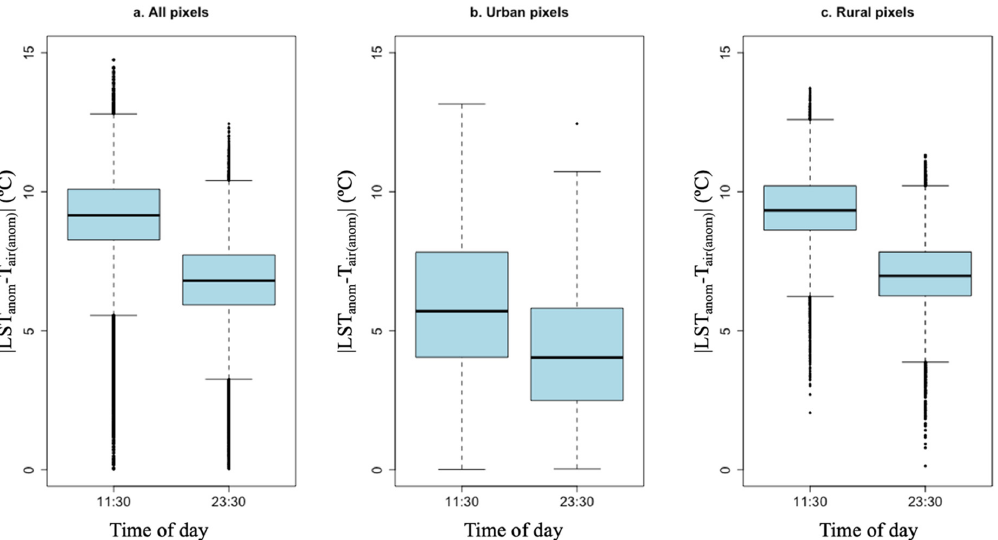
Figure 3. The absolute magnitude of the difference between LST anom and T air(anom) by time of day, averaged over all 15 dates of study across ( a ) all pixels, ( b ) all urban pixels, and ( c ) all rural pixels. Urban pixels are all those categorized as higher and lower density development, and rural pixels are all those categorized as forest, agriculture, grasslands, barren, or wetlands.